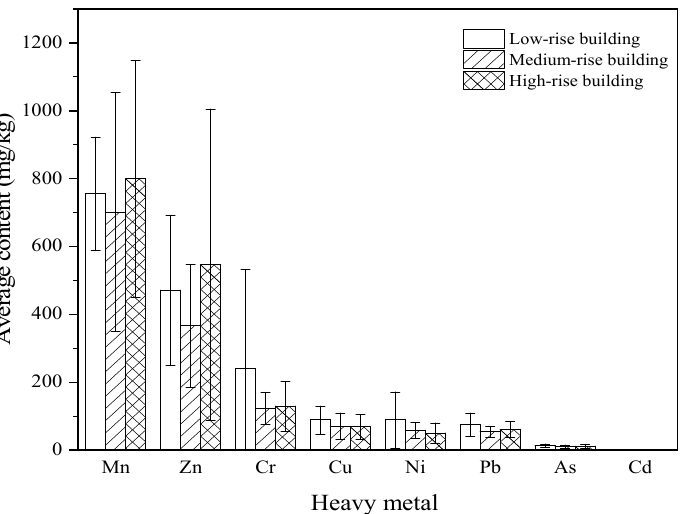
Figure 2. Variations in the average heavy metal content in the dust fall on low-, medium-, and high-rise buildings. Table 4. Statistics of heavy metal elements in dust fall on various buildings.